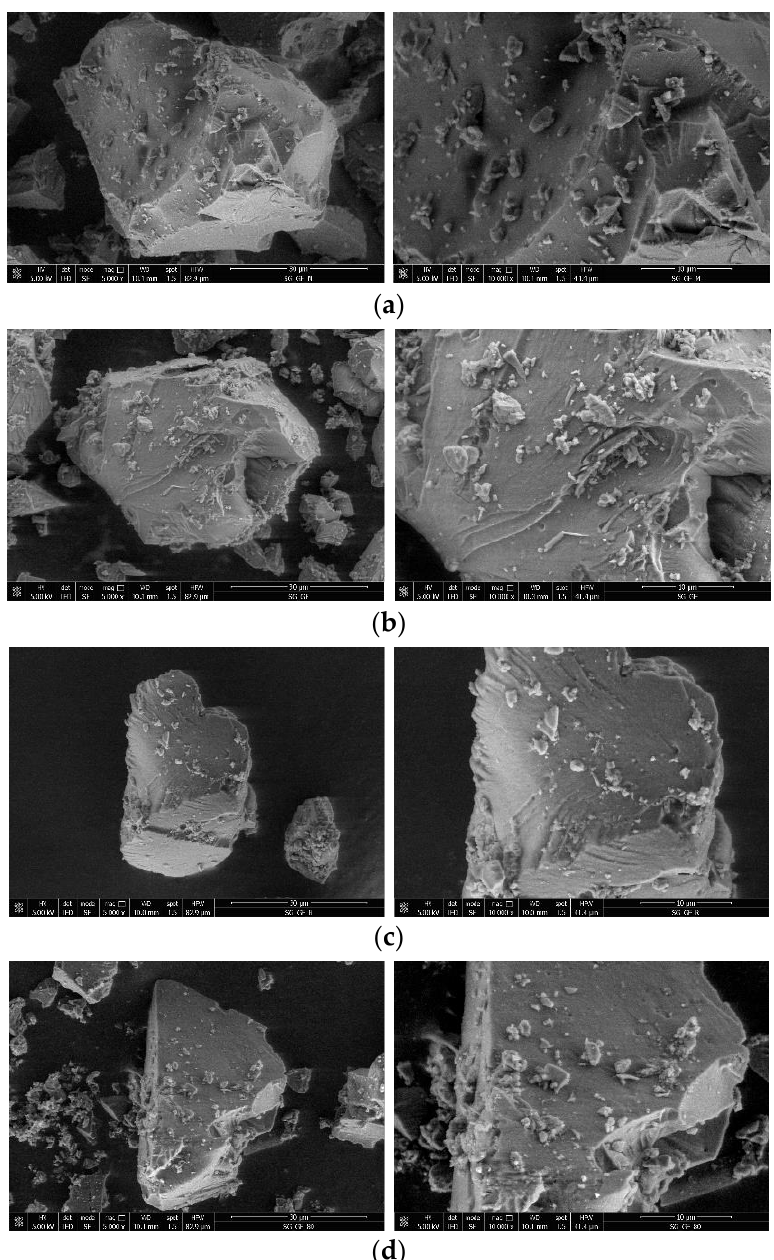
Figure 7. SEM micrographs at 5000 × and 10,000 × magnification of the: ( a ) blank sol-gel matrix; ( b ) sol-gel-entrapped Candida antarctica B lipase; ( c ) the recovered sol-gel biocatalyst after repeated use; ( d ) the recovered sol-gel biocatalyst after thermal stress.